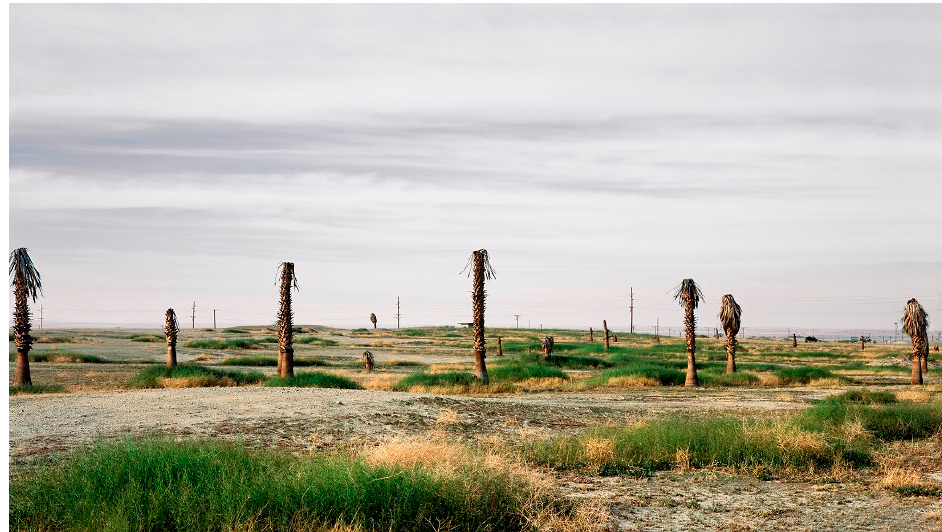
Figure 28. Anthony Hernandez, Discarded #12 (2013), © Anthony Hernandez. Arts 2019 , 8 , x FOR PEER REVIEW